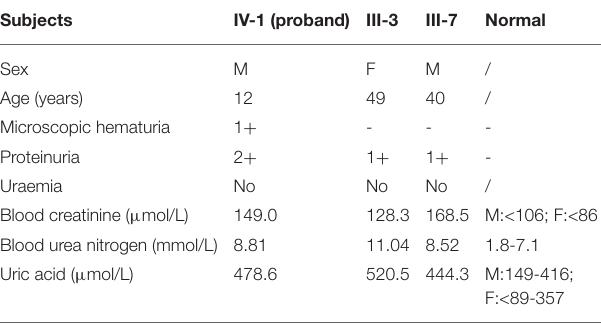
TABLE 1 | Clinical data of three patients in this family.